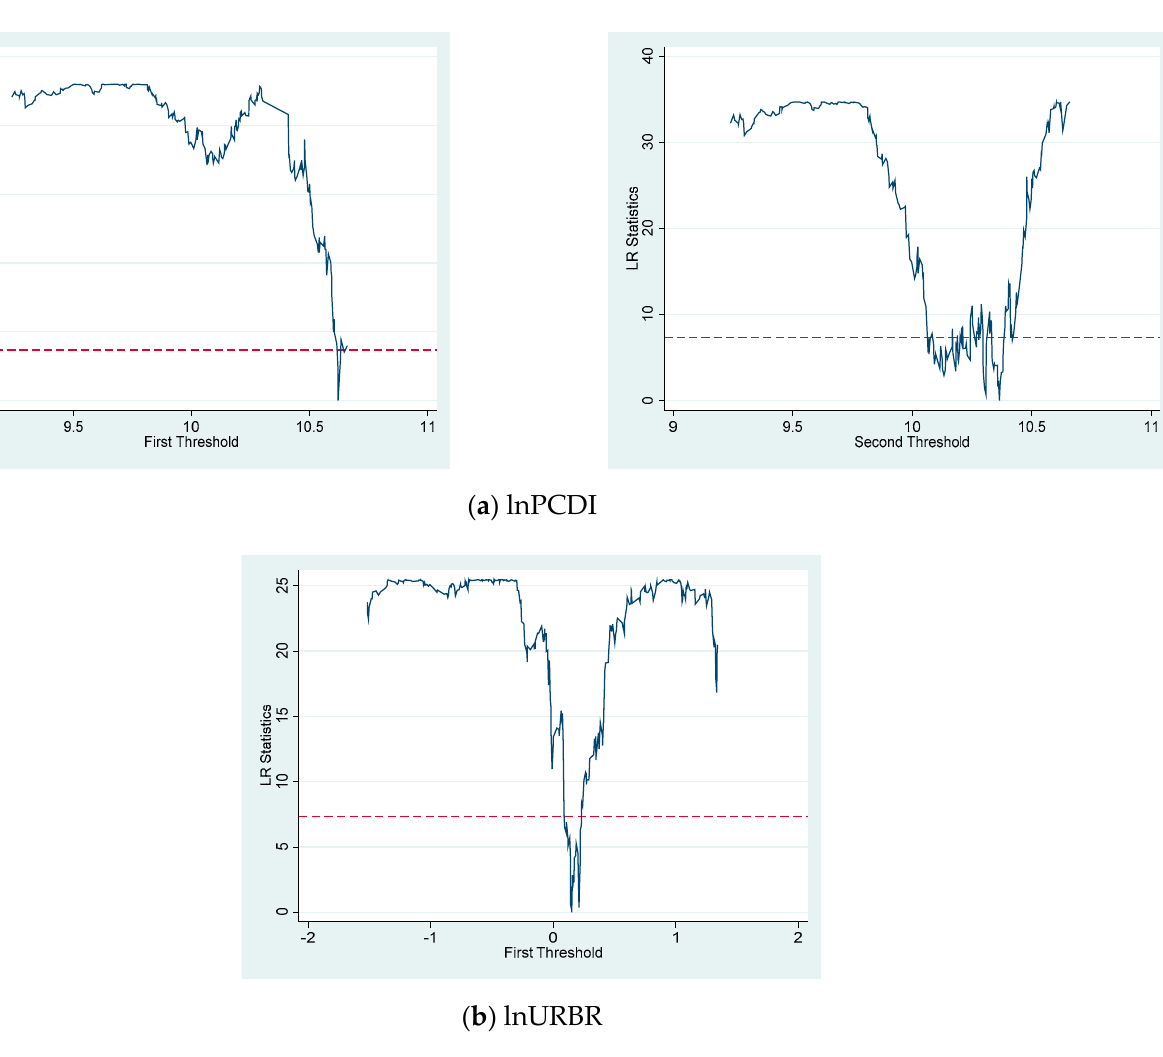
Figure 4. Likelihood − ratio (LR) diagram with the threshold variable lnPCDI and lnURBR.